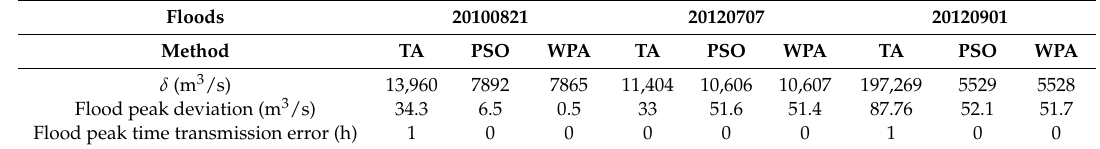
Figure 5. Correlation of observed and simulation data. Table 8. Analysis of Ankang hydropower station – Ankang city simulation results.